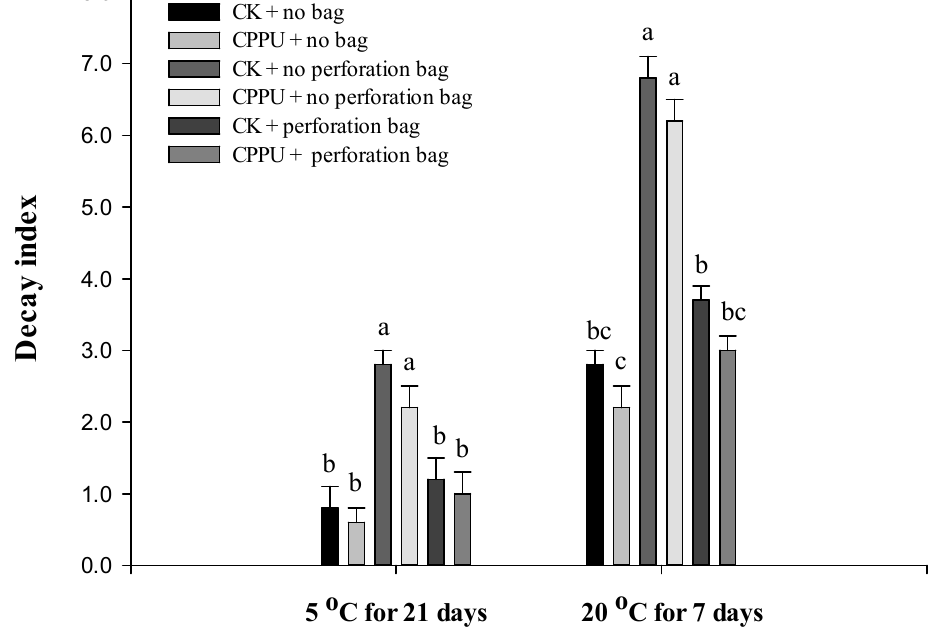
Figure 4. The effect of preharvest application of CPPU and perforation packaging on decay index (DI) of red-fleshed pitaya ‘Da Hong’ fruit at 5 °C for 21 days storage and transferred to 20 °C for 7 days. Bars represent means of ten replications ± SD ( n = 4). Means with different lowercase letters are significant differences ( p < 0.05).